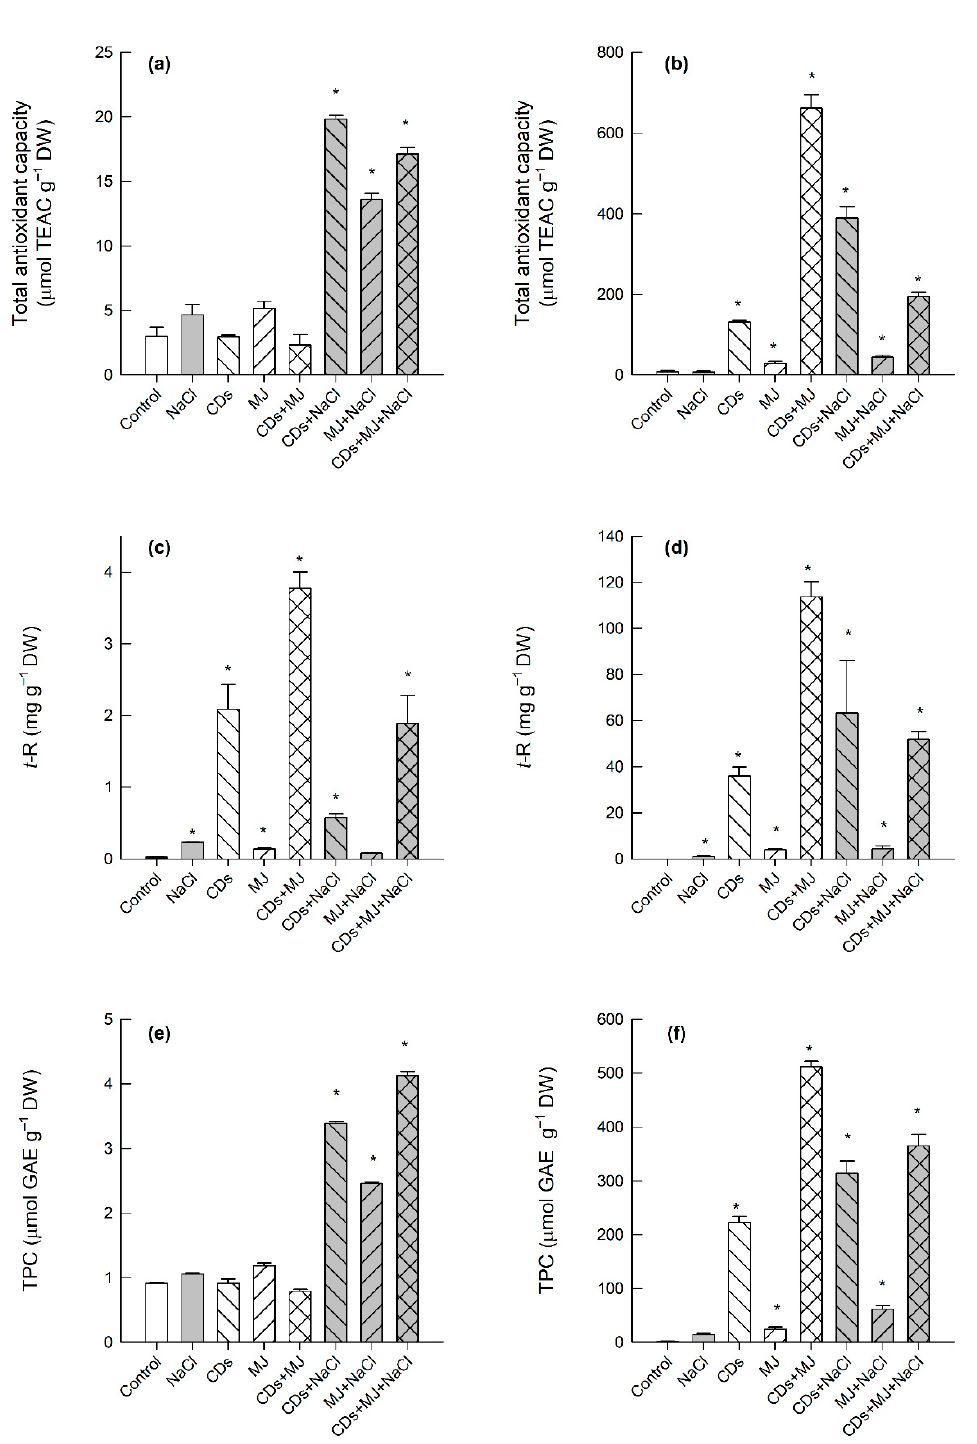
Figure 2. The effects of salt and/or elicitor treatments on the total antioxidant capacity (TAC) ( a , b ), t -R levels ( c , d ), and the total phenolic content (TPC) ( e , f ) in intracellular (left; ( a , c , e )) and extracellular (right; ( b , d , f )) extracts of Monastrell SCC. The data represent the mean ± SE of three independent experiments. Treatments marked with an asterisk are significantly different from the control ( p < 0.05) by Tukey’s HSD